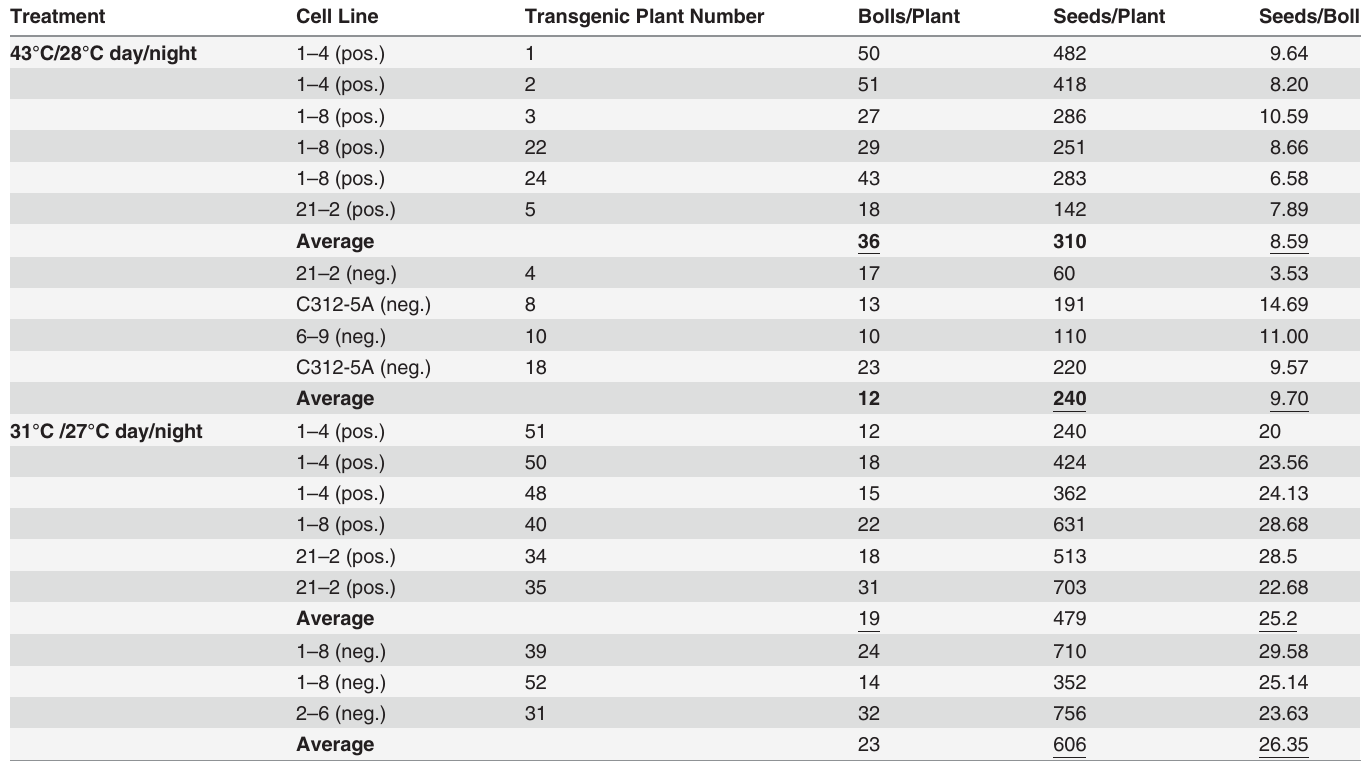
Table 1. Characterization of the heat tolerance of AtHSP101 plus and AtHSP101 minus cotton plants from different cell lines. Treatment Cell Line